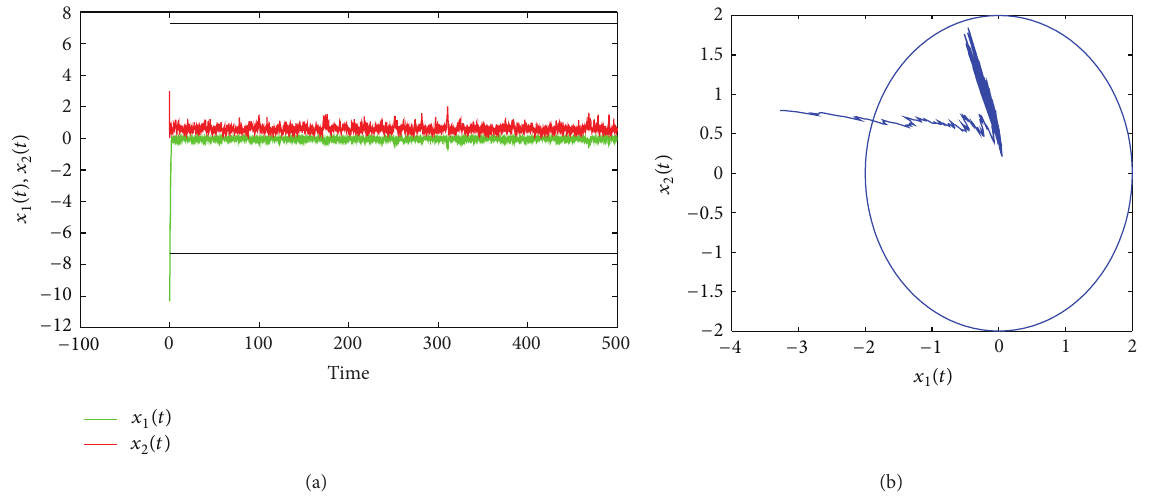
Figure 1: Time trajectories (a) as well as the phase portrait (b) for the system in Example